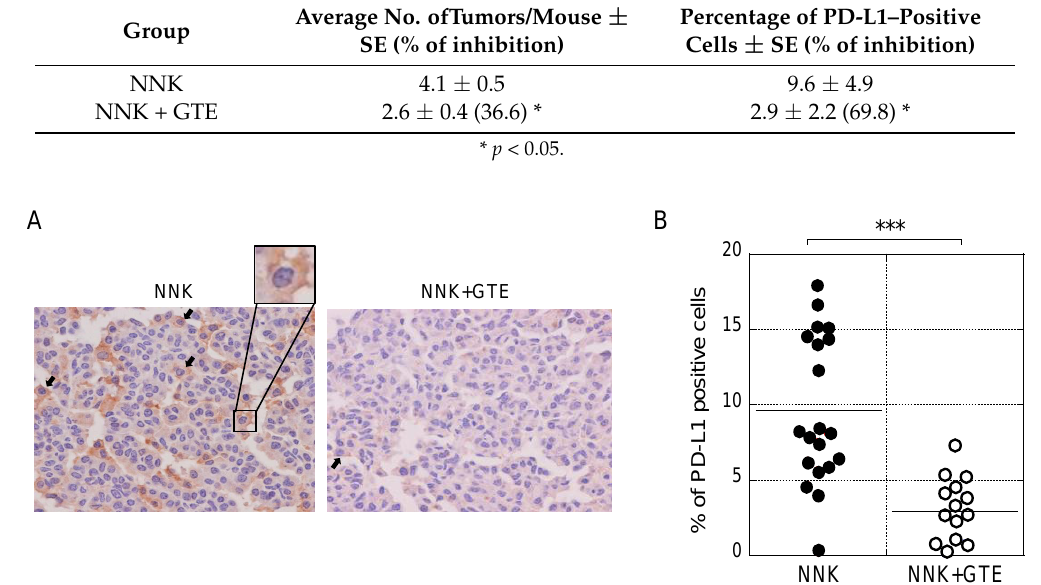
Table 1. Oral administration of GTE reduced average number of lung tumors and percentage of PD-